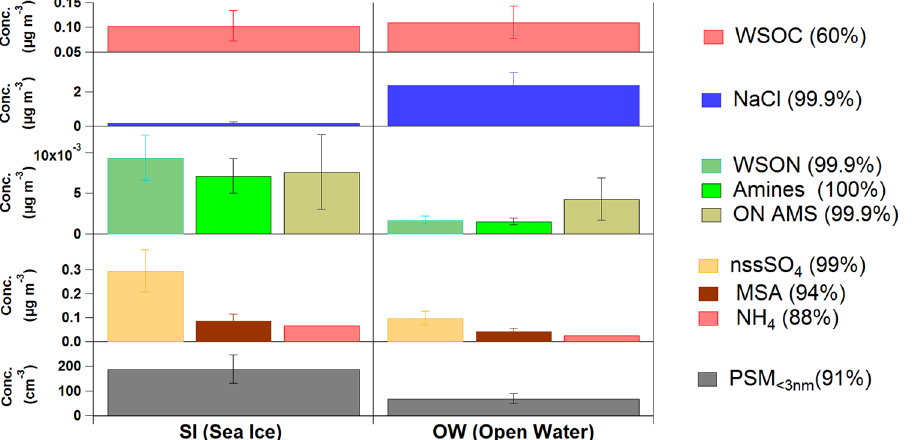
Figure 1. Characteristics of collected aerosols according to their origin. Average and standard deviations are given for aerosol chemical composition and ultrafine particle concentrations in air masses with (left, SI, n = 3) and without (right, OW, n = 3) sea ice influence. WSOC, NaCl, WSON, amine (sum of alkyl-amines), nssSO 4 , MSA and NH 4 (ammonium) are given as mass collected on filters; ON AMS is organic nitrogen-containing m/z fragments measured continuously in situ ; N is number concentration of particles in the size range 1–3 nm. The % probability that SI and OW averages are different is given in